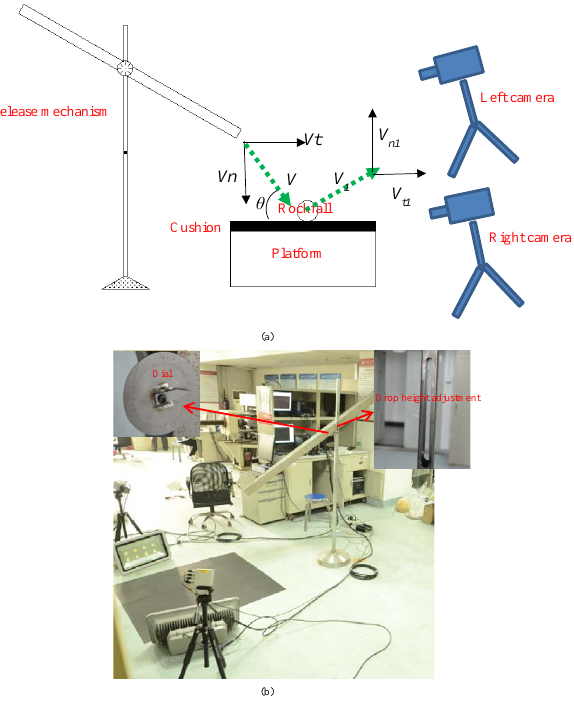
Figure 3. The experimental apparatus. (a) Model; (b)